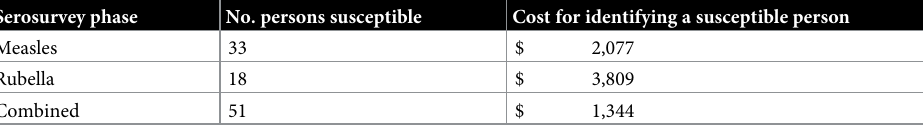
Table 2. Costs per susceptible participant identified in 2016 serosurvey in Southern Province, Zambia.